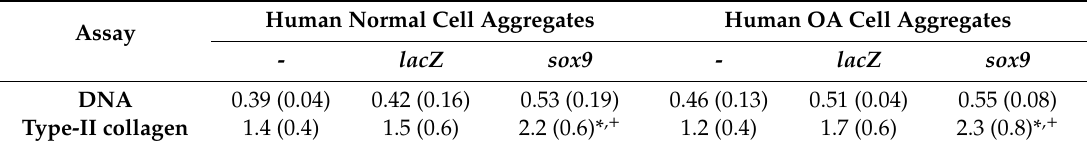
Table 2. Biochemical analyses in rAAV-transduced aggregate cultures of human normal and OA chondrocytes (day 21).